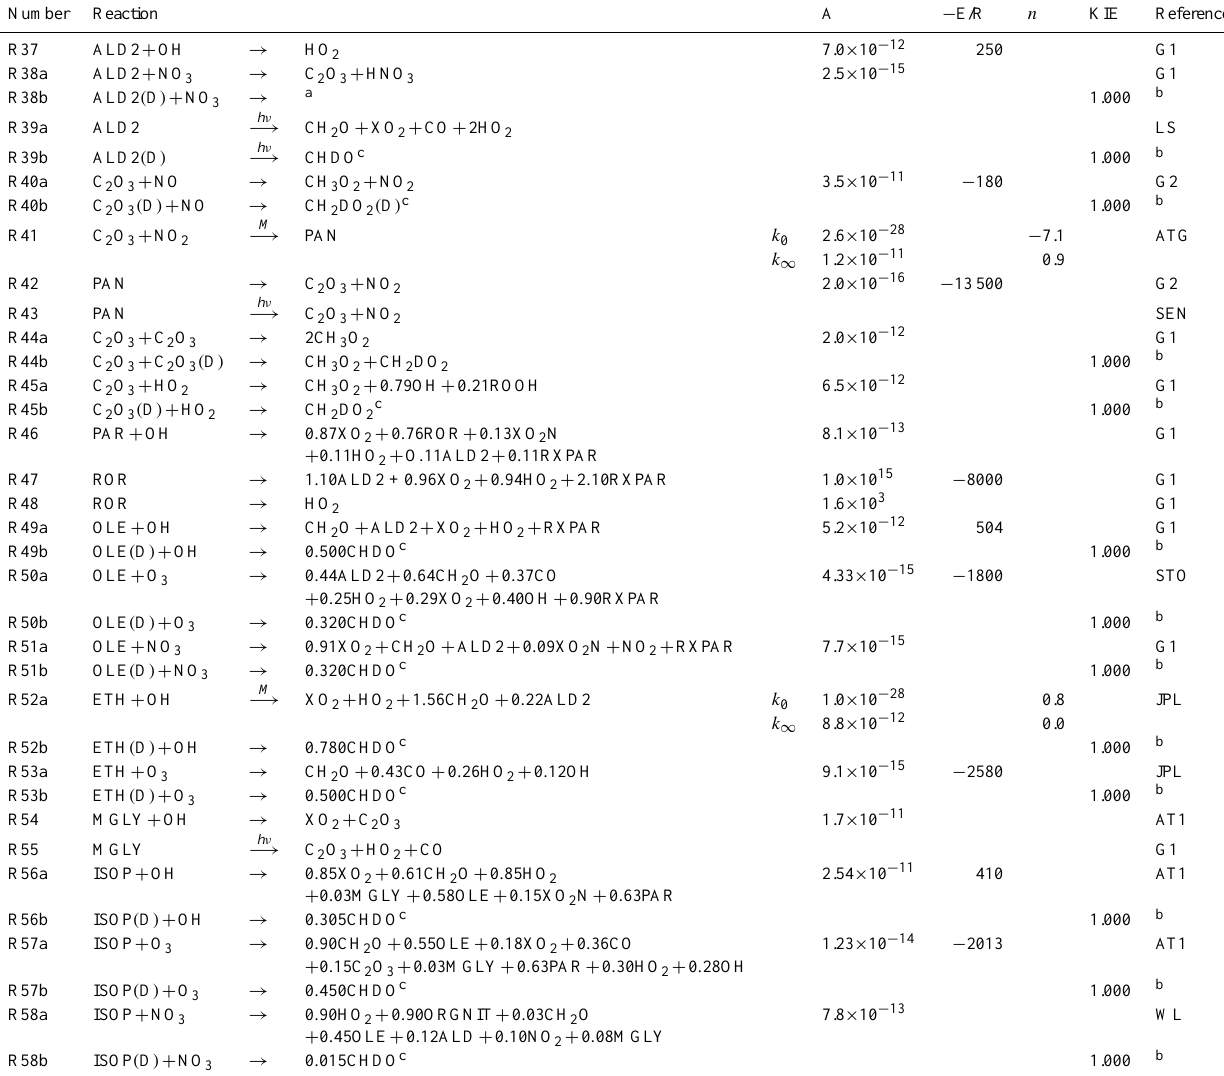
Table B1. Overview of modified CBM-IV NMHC reactions. Number Reaction